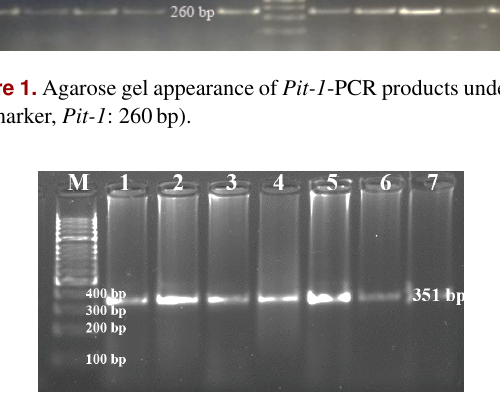
Figure 2. Agarose gel appearance of CSN3 -PCR products under UV (M: marker, CSN3 :